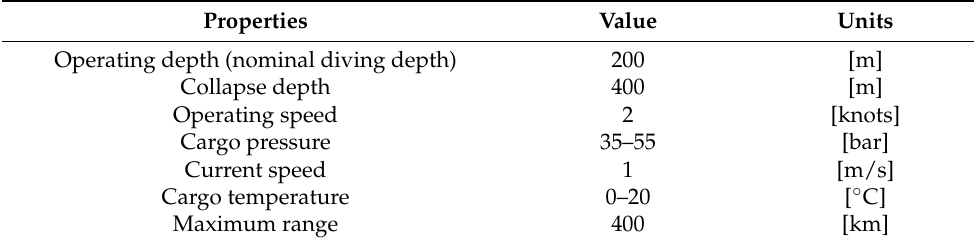
Table 1. Operating specifications.